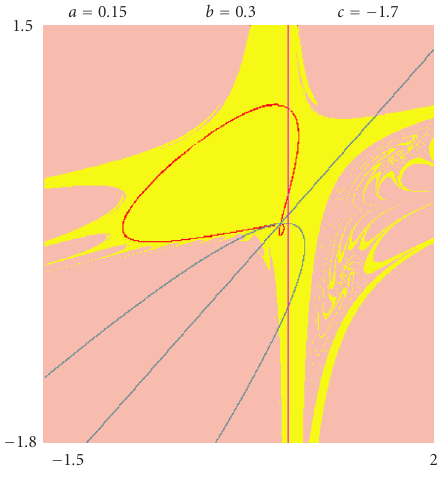
Figure 4.4. Formation of a loop after the crossing of the focal point.